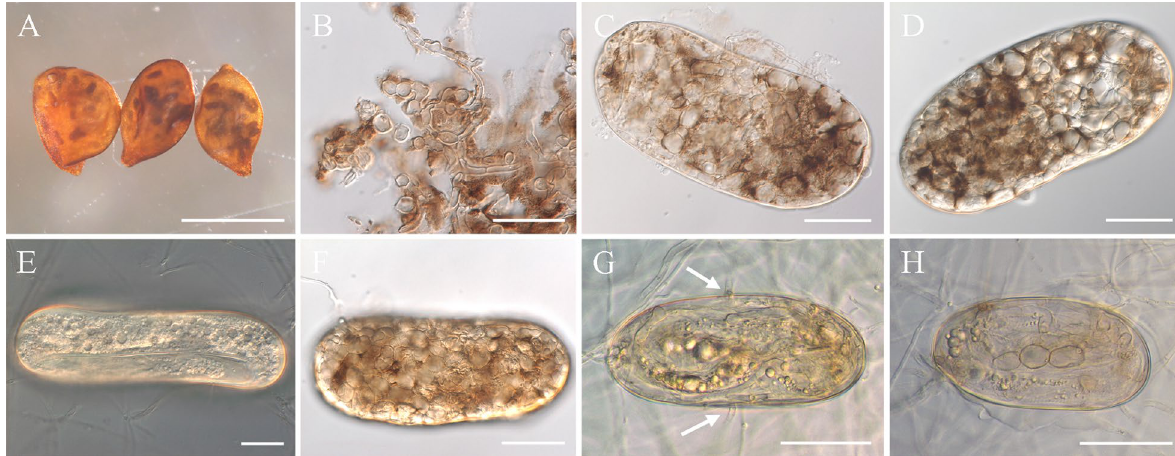
Fig. 4 Pathogenicity of Polydomus karssenii DSM 106825 towards nematode cysts and eggs. a Symptomatic cysts of Heterodera filipjevi obtained from in vitro pathogenicity tests, exhibiting black eggs infected by the fungus. b Highly melanised running hyphae of Polydomus karssenii growing in cyst mucilage within the cysts cavity. c–e Fungal‑infected eggs of Heterodera filipjevi : c Naturally occurring egg from field collected cyst samples infested by Polydomus karssenii (image from Helaly et al. (2018a), d Infested egg obtained from a cyst infected by the fungus during incubation on the fungal colony during in vitro tests, e Early stage of fungal colonisation observed in slide culture studies. Note deformation of the body cavity of the developing juvenile. f–h Fungal infected eggs of Heterodera schachtii : f Fungal infected egg obtained from a symptomatic cyst incubated on the fungus during in vitro pathogenicity tests; g , h In vitro infection process of Polydomus karssenii in nematode eggs: direct penetration of the fungus through the egg shell (indicated by arrows) and growing inside the body cavity of the developing juvenile ( g ), Development of the fungus inside the nematode body forming thick‑walled moniliform hyphal cells ( h ). Bars 0.6 mm ( a ), 30 µm ( b – d , f ), 20 µm ( e ), 50 µm ( g , h =